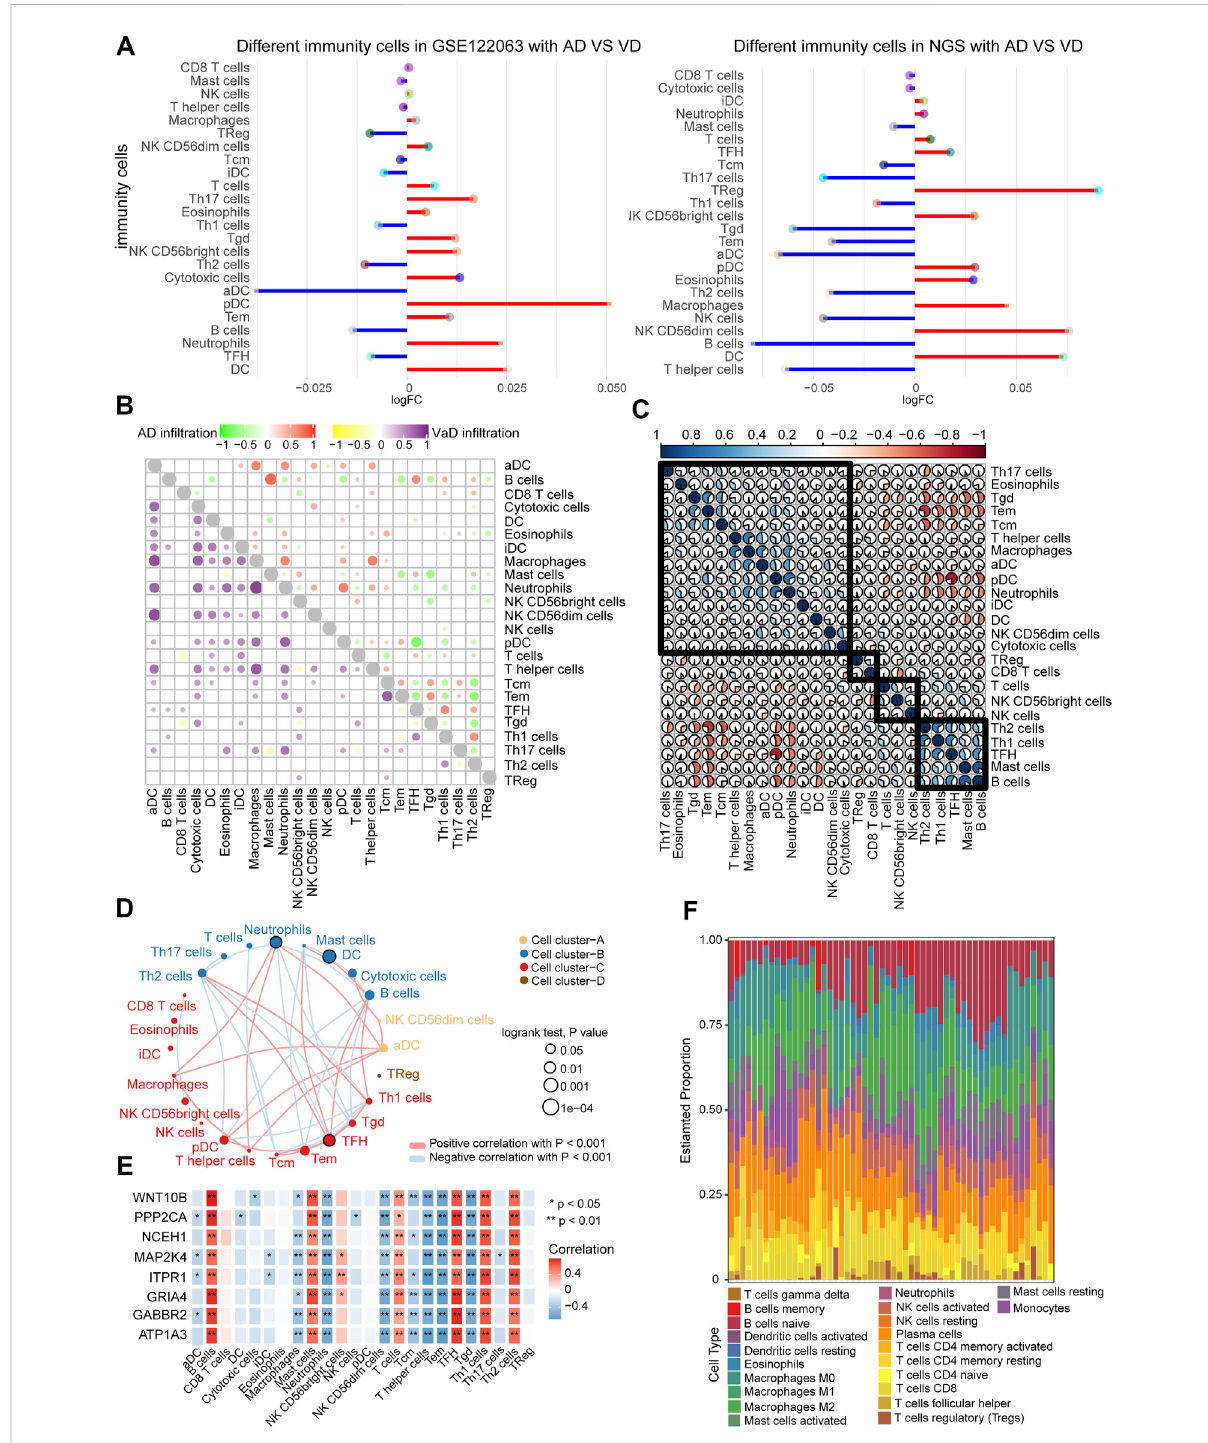
FIGURE 6 CorrelationbetweenimmunecellsinADandVD. (A) ExpressionofdifferentiallyabundantimmunecellsintheGSE122063andNGSdatasets. (B) Correlation between immune cell types in AD and VD. Red and purple represent positive correlations, and green and yellow indicate negative correlations. (C) Correlationbetweenimmunecells.Thebluesectionindicatesactivation,andtheorangesectionindicatesinhibition. (D) Networkof immune cell types (abundance). Circles represents the prognostic effect of the cell type, and the thickness of the line indicates the strength of correlations between the cell types. (E) Correlation between immune cell types and the eight featured genes. (F) Estimated proportions of immune cell types in AD. AD, Alzheimer ’ s disease; VD, vascular